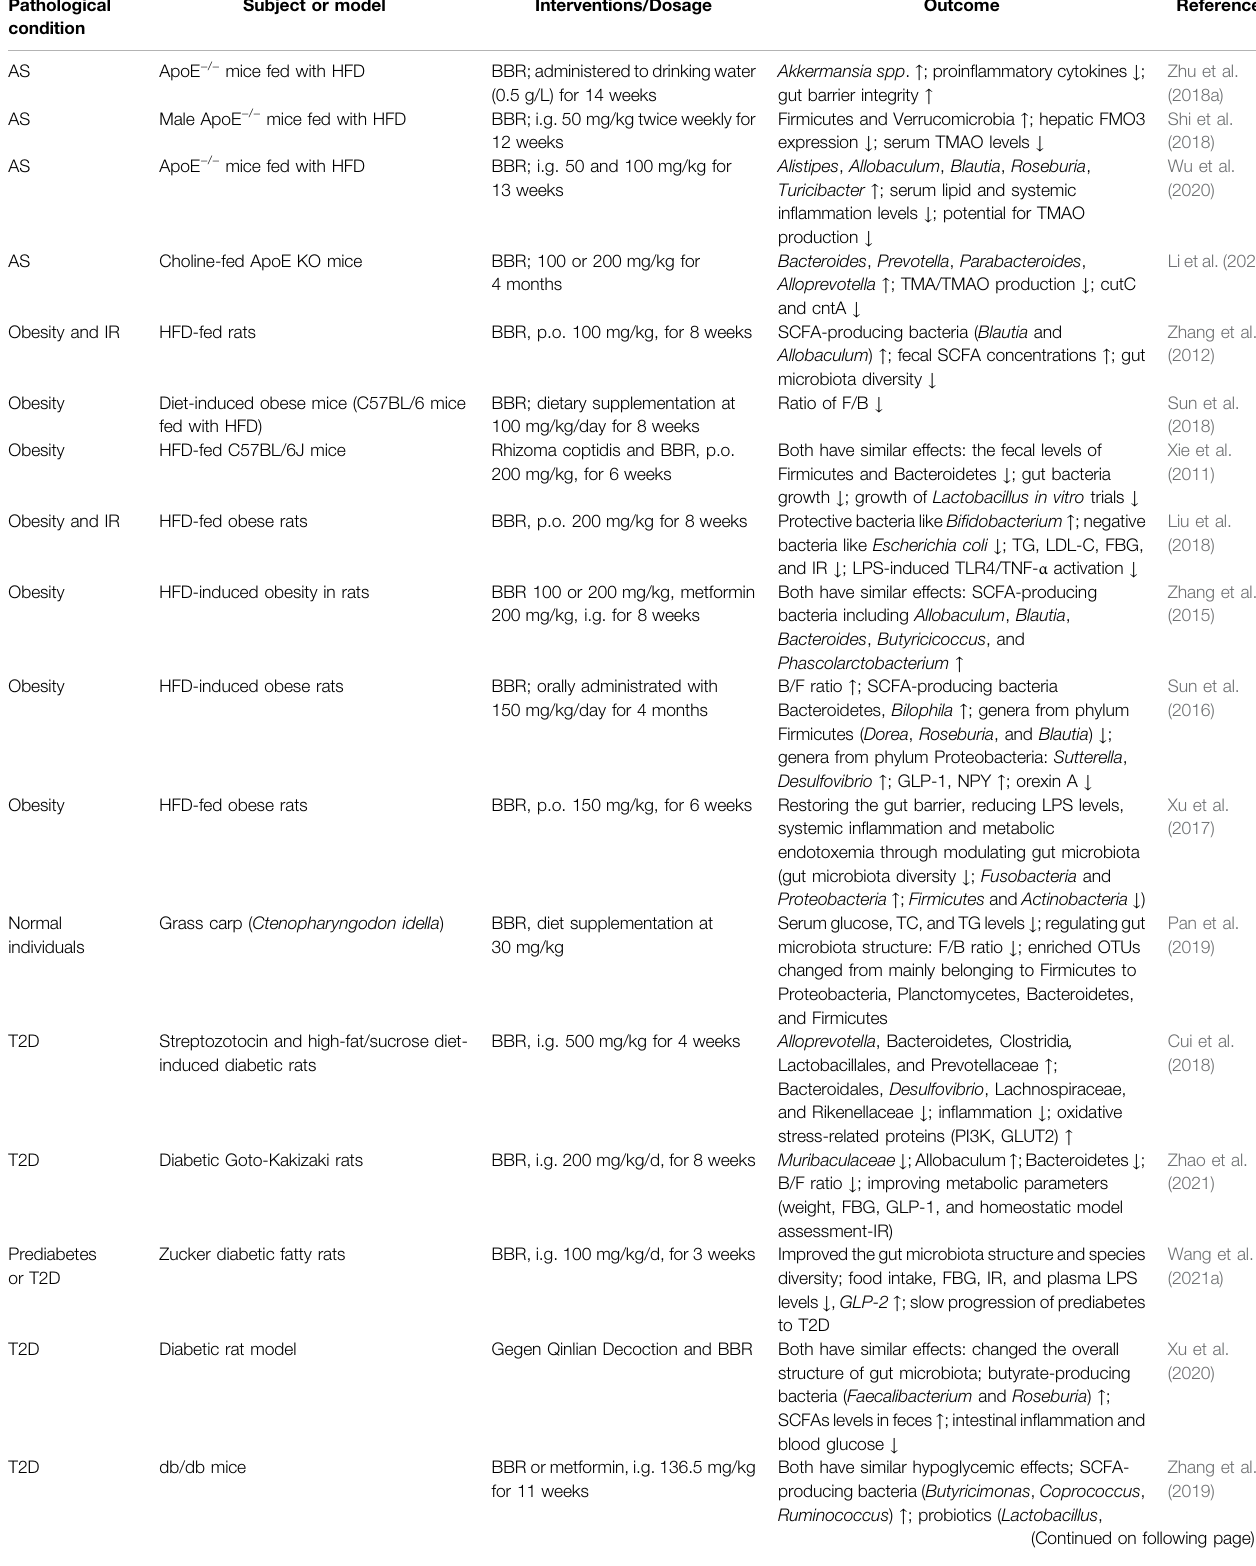
TABLE 1 | BBR-mediated structural and compositional alterations in the gut microbiota in AS and metabolic diseases. Pathological